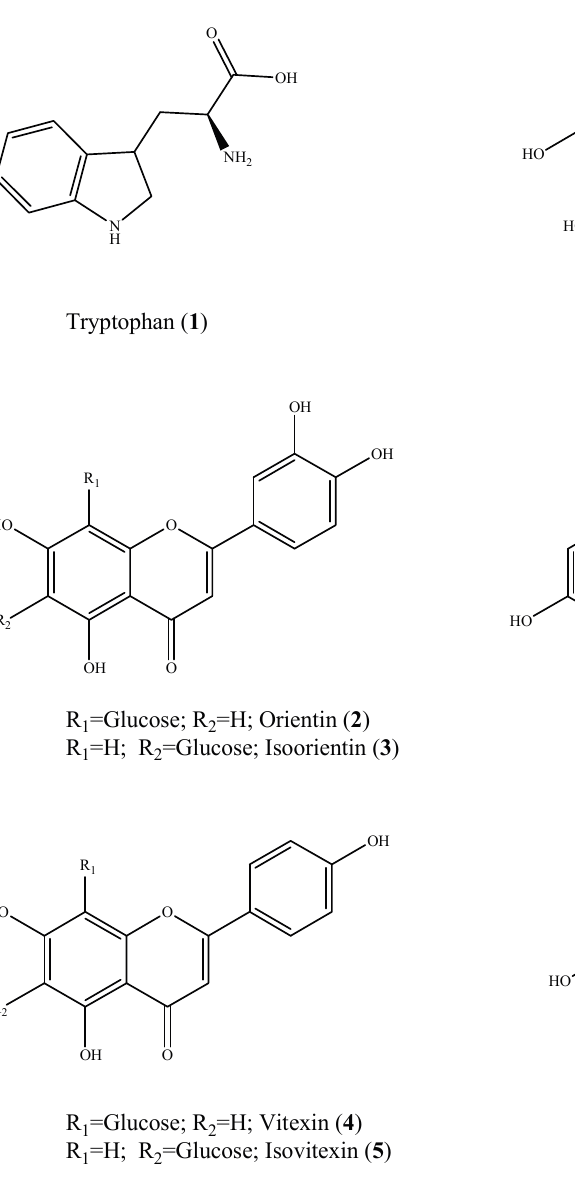
(Table 2). The inhibitory activity of 8-C-glucosyl 3',4',5,7-tetrahydroxy flavone was a slightly stronger than that of 6-C-glucosyl [25]. 6-C-glucosyl and 8-C-glucosyl flavone showed more potent activity than the 7-C-glucosyl